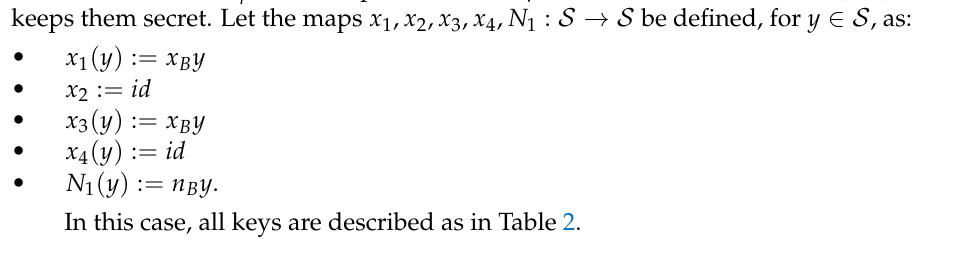
Table 2. Complete list of key of example algorithm of